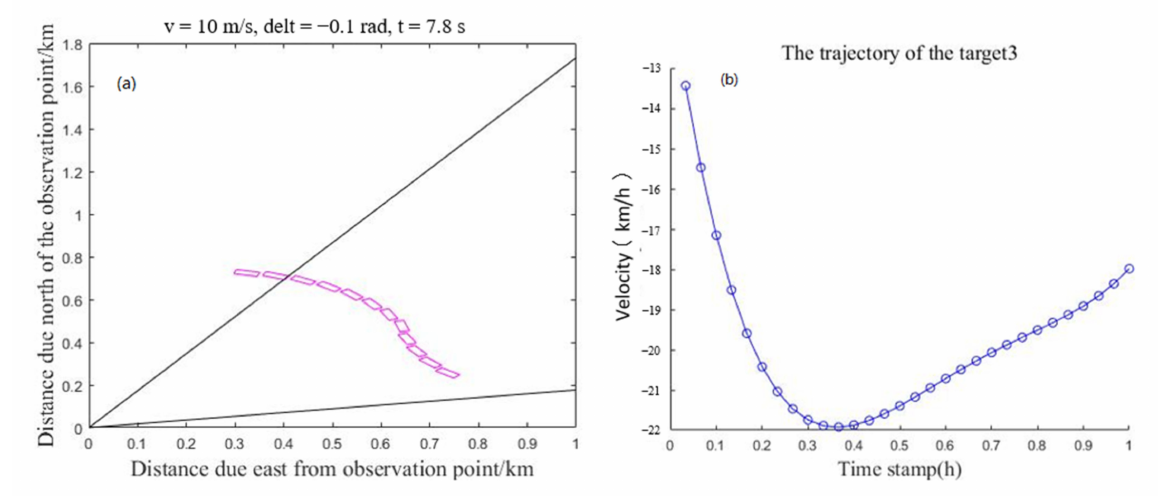
Figure 12. Simulation intention prediction results of direct ship. ( a ) Simulation of ship movement trajectory. ( b ) Ship speed and direction.